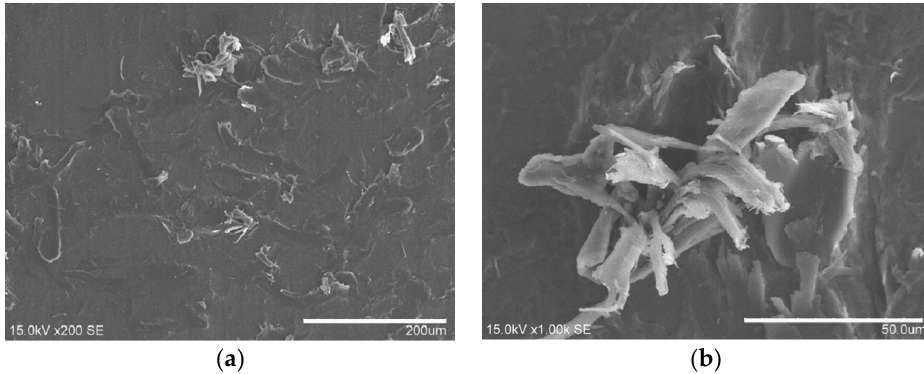
Figure 23. SEM image of the wear surface of 5% PPTA filled PTFE: ( a ) the magnification 200×; ( b ) the magnification 1000×.